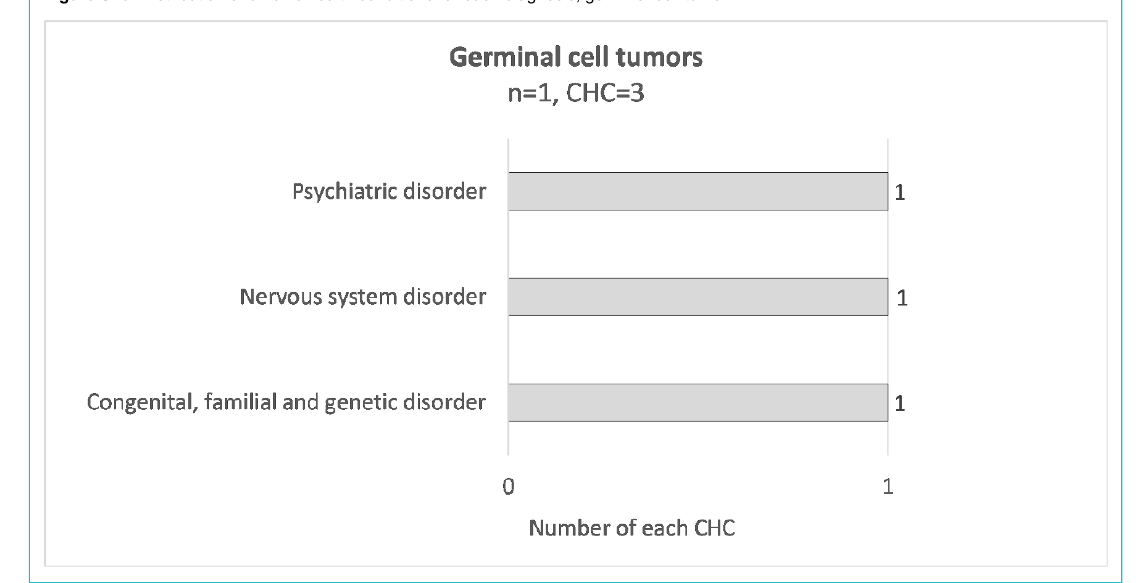
Figure S10: Distribution of chronic health conditions for each diagnosis; germinal cell